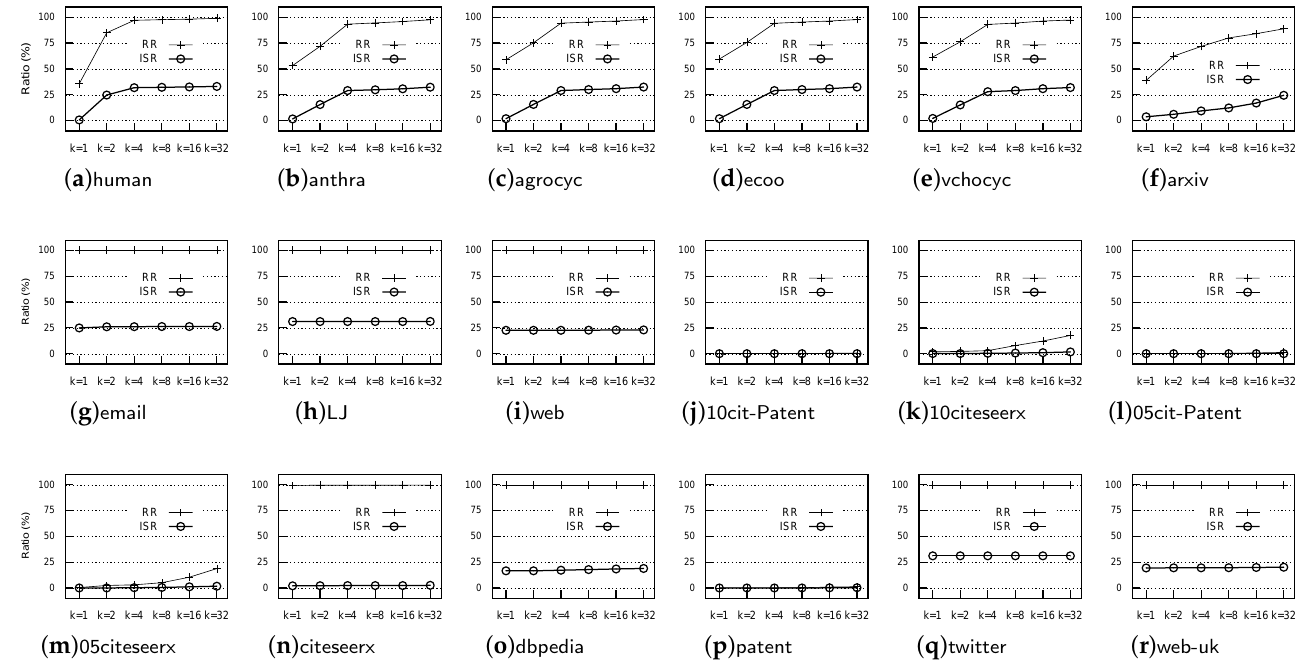
Figure 5. Comparison of the Reachability Ratio (RR) and Index-Size Ratio (ISR), where ISR is ratio of the index size of p2HL s, with respect to k hop nodes, over that of the total 2-hop label size with respect to all